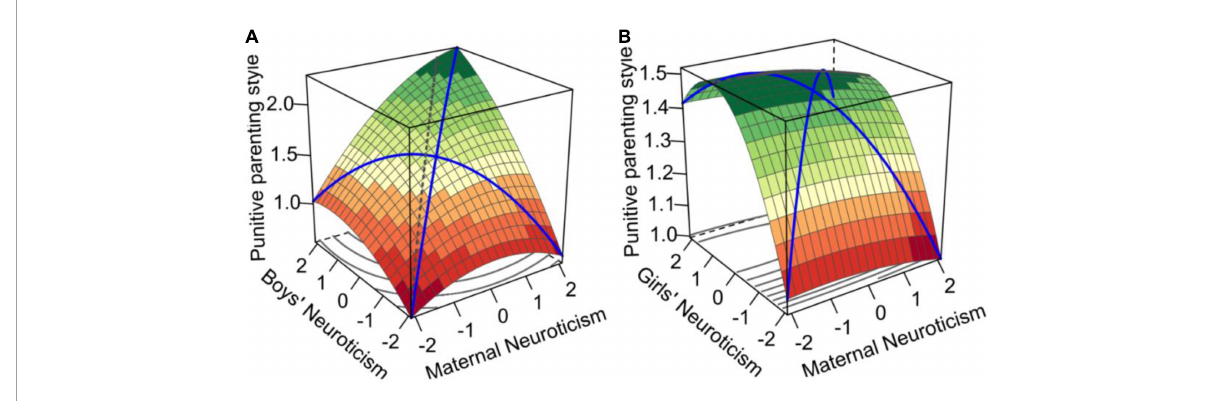
FIGURE3 Congruence effect and asymmetrical incongruence effect of maternal–adolescent neuroticism on punitive parenting style in different genders (A) for boys and (B) for girls.